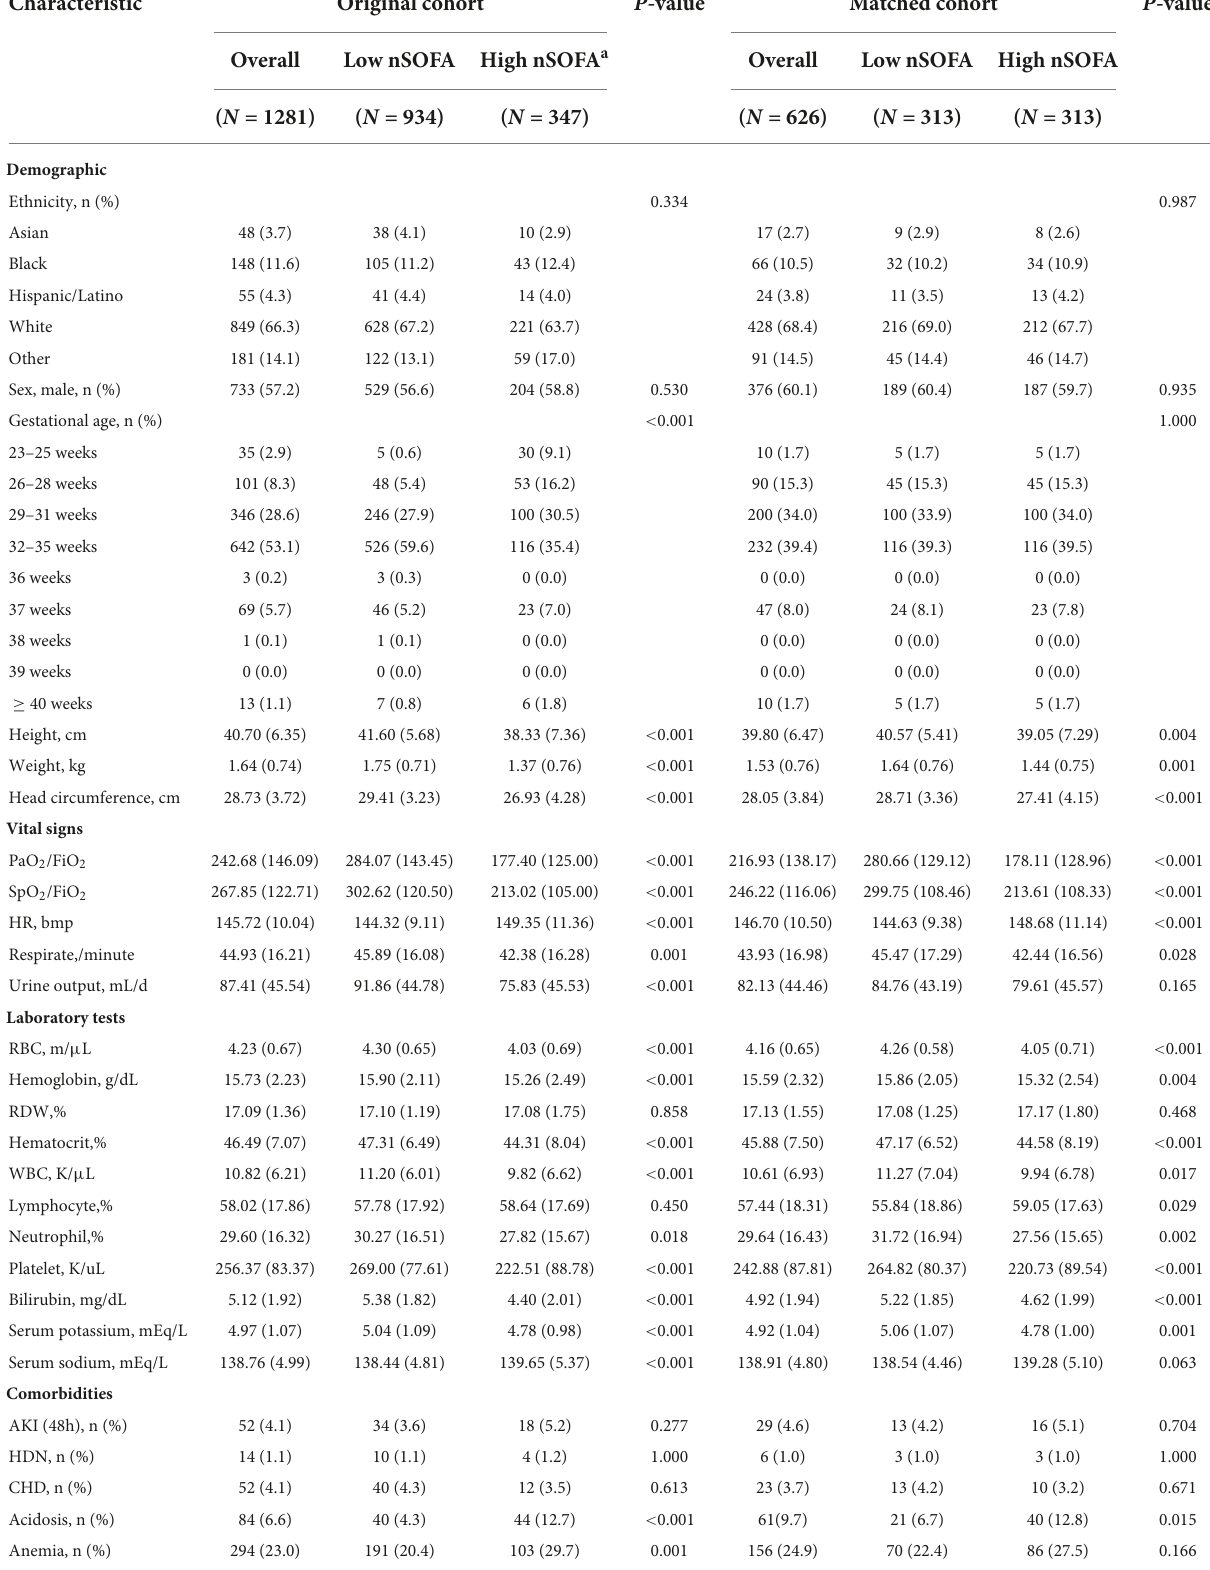
TABLE 2 Demographic data and comparisons between the low and high nSOFA